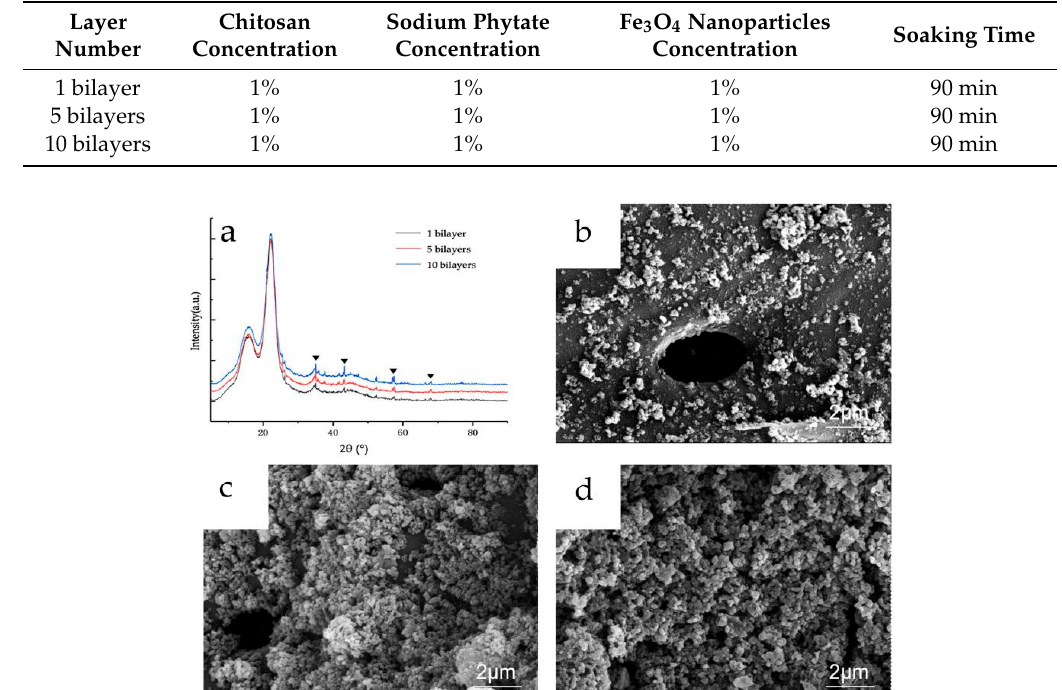
Table 1. Reaction factors of the modified wood samples with multiple layers.